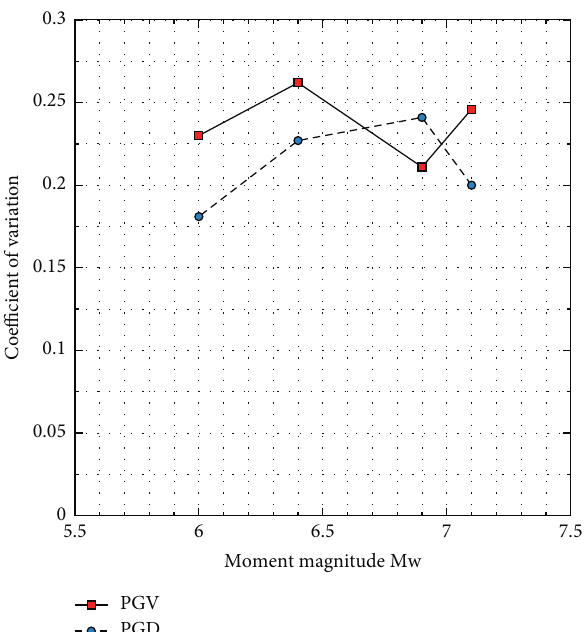
Figure 9: Comparison of the coefficients of variation for the peak ground velocity and displacement as a function of the earthquake